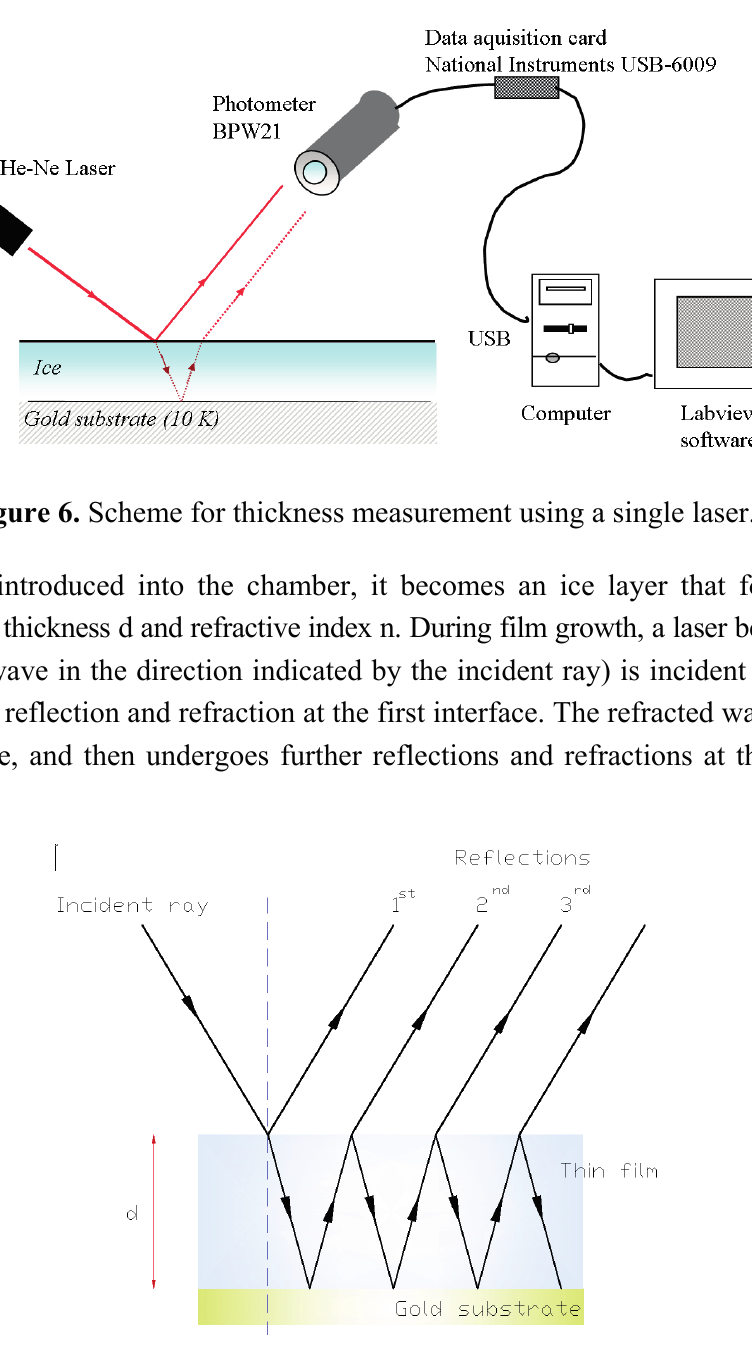
Figure 7. Multiple reflections in a thin